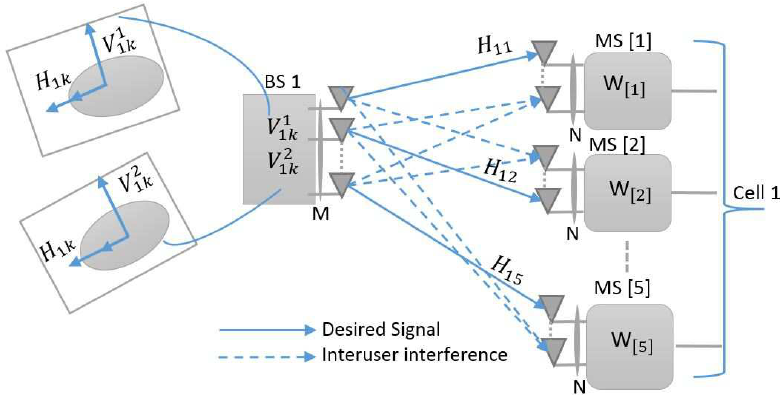
Figure 1. Multiple-input-multiple-output Gaussian interference channel for five users per cell ( K = 5 and L =